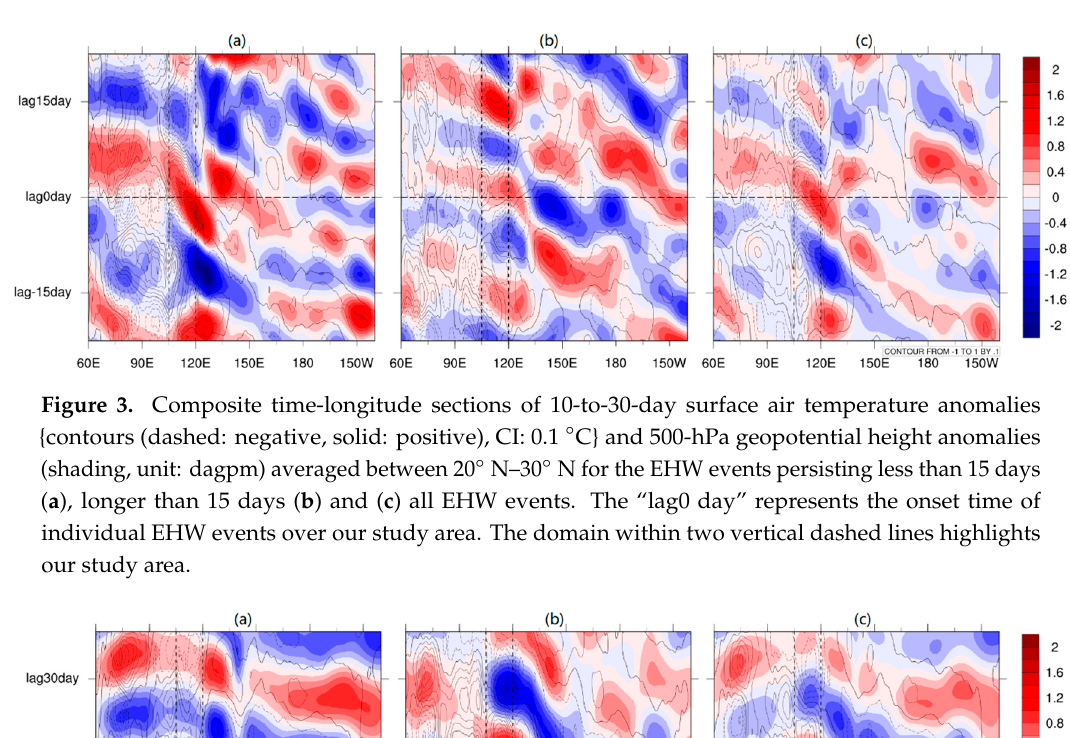
Figure 3. Composite time-longitude sections of 10-to-30-day surface air temperature anomalies {contours (dashed: negative, solid: positive), CI: 0.1 °C} and 500-hPa geopotential height anomalies (shading, unit: dagpm) averaged between 20° N–30° N for the EHW events persisting less than 15 days ( a ), longer than 15 days ( b ) and ( c ) all EHW events. The “lag0day” represents the onset time of individual EHW events over our study area. The domain within two vertical dashed lines highlights our study area.